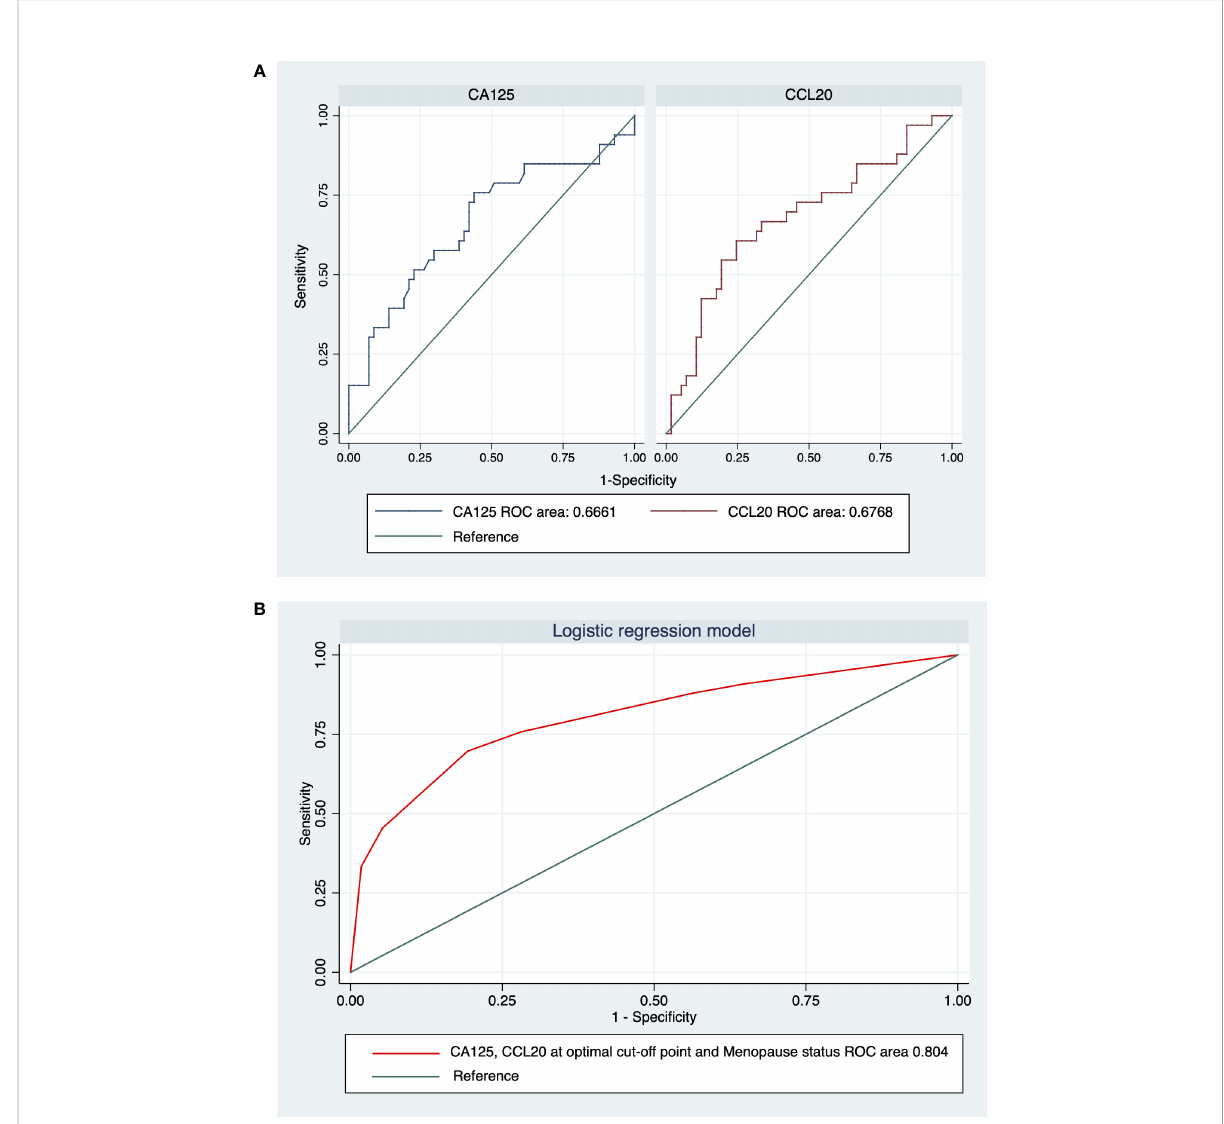
FIGURE 5 Receiver-operating characteristic (ROC) curve analysis and areas under the curve (AUC) for (A) CA125 and CCL20 and (B) the logistic regression model integrating CA125, CCL20, and menopause